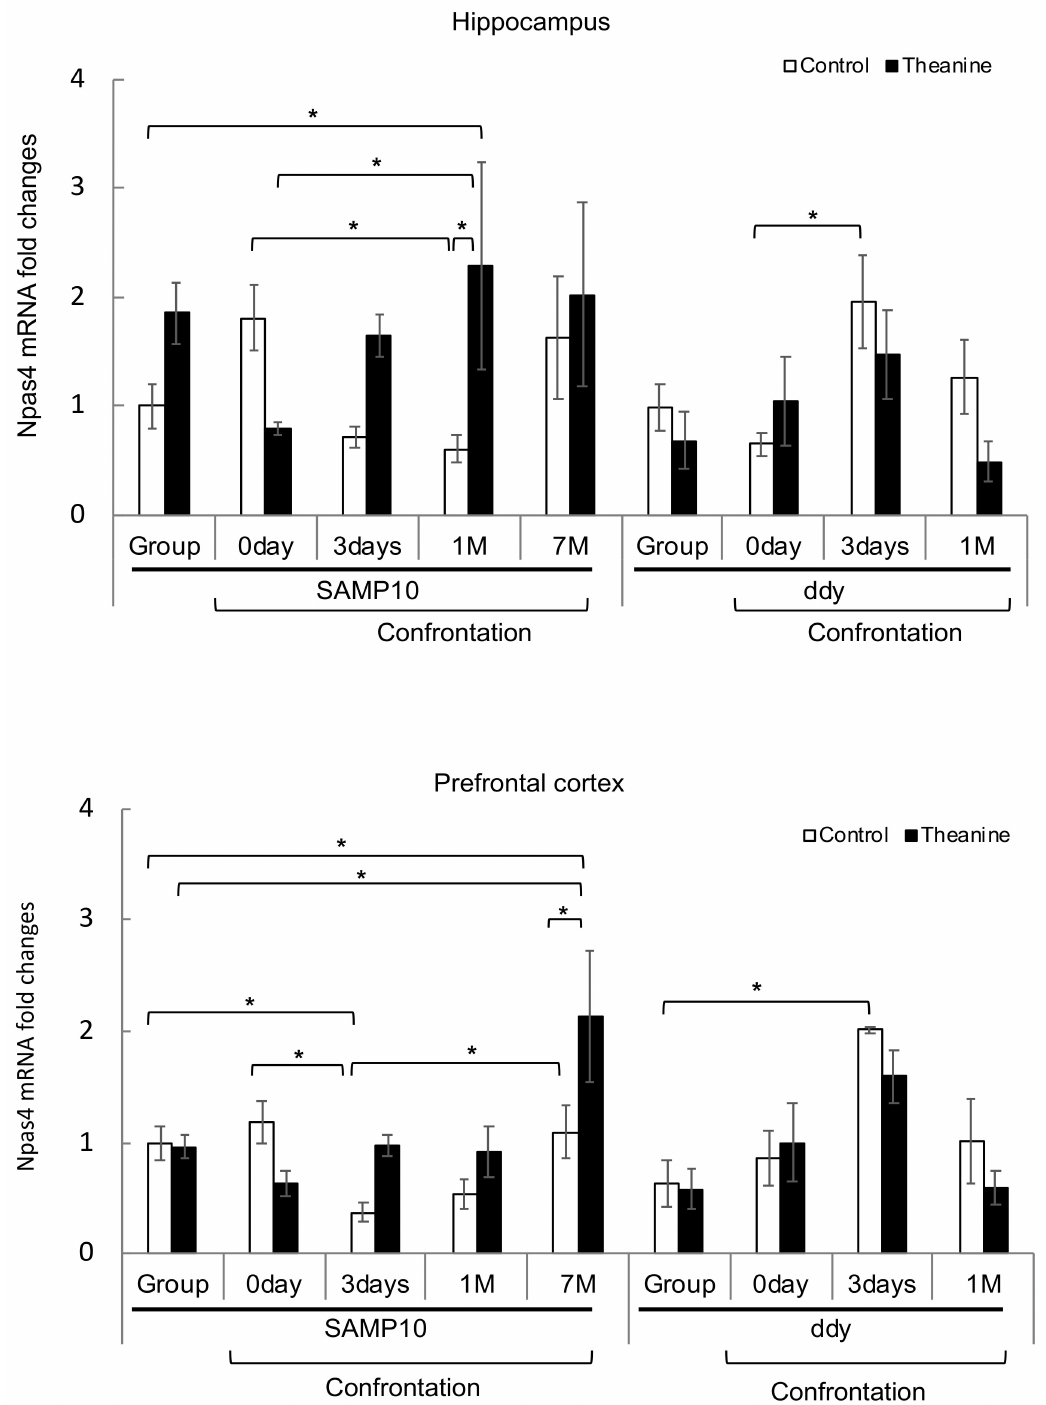
Figure 6. Expression levels of Npas4 mRNA in the hippocampus and prefrontal cortex of SAMP10 and ddY mice. Mice consumed theanine (20 µ g / mL water, closed bar) or normal tap water (control, open bar) ad libitum. After single housing for one month, hippocampal and prefrontal cortex samples were obtained from mice housed confrontationally for 0 days, 3 days, 1 month, and 7 months. Group-housed mice were kept in a cage for two months. Values are expressed as means ± SEM ( n = 3–6, * p <